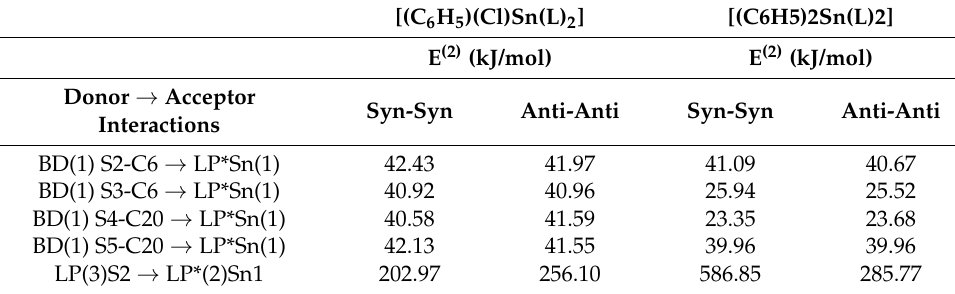
Table 1. Selected second-order perturbation energy